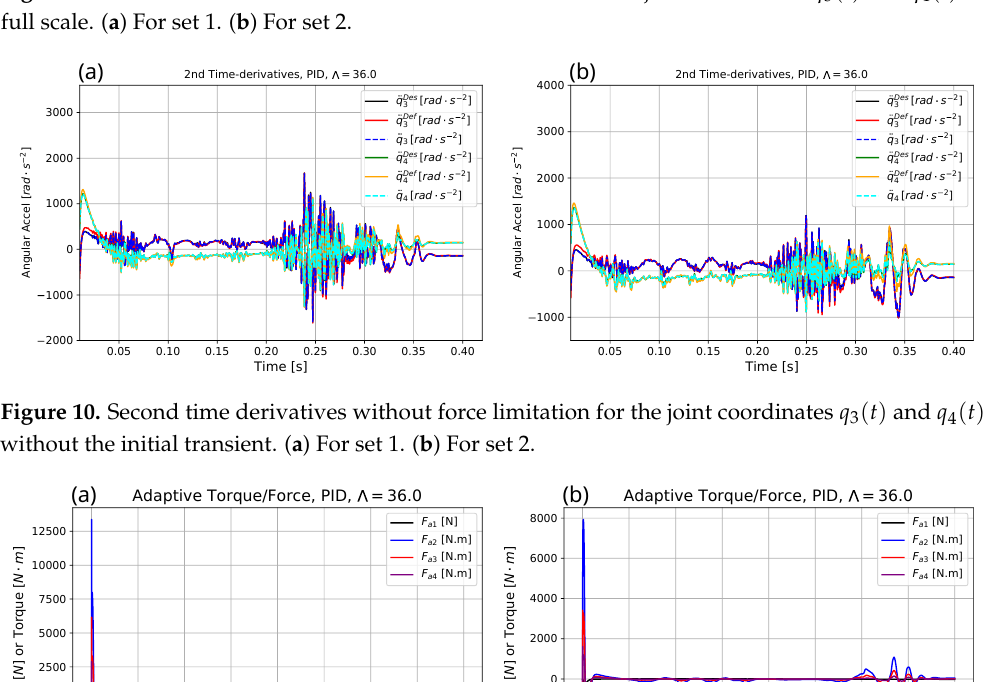
Figure 9. Second time derivatives without force limitation for the joint coordinates q 3 ( t ) and q 4 ( t ) in full scale. ( a ) For set 1. ( b ) For set 2.